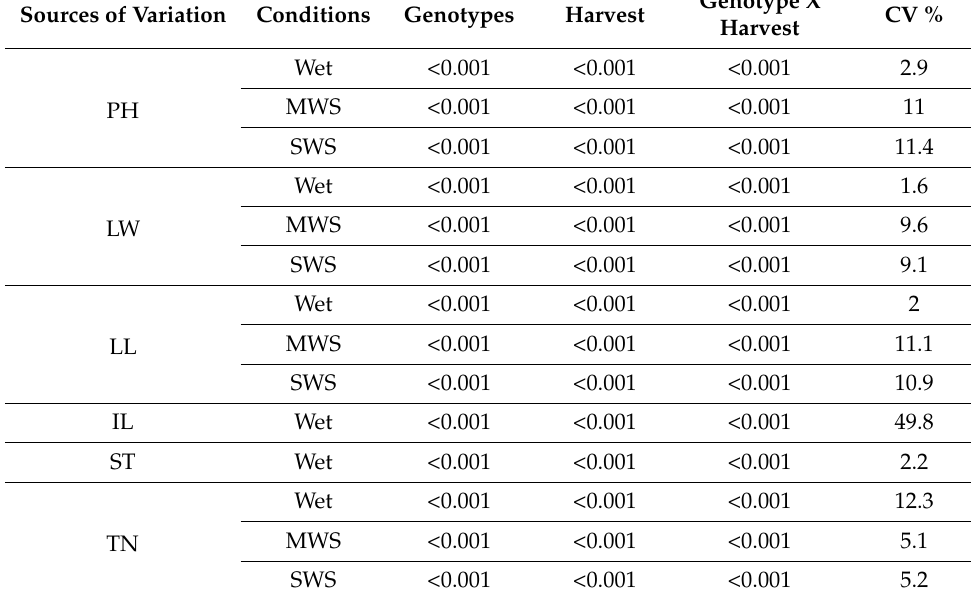
Table A2. ANOVA summary of agro-morphological traits of 84 Napier grass genotypes in wet, moderate water stress (MWS) and severe water stress (SWS)